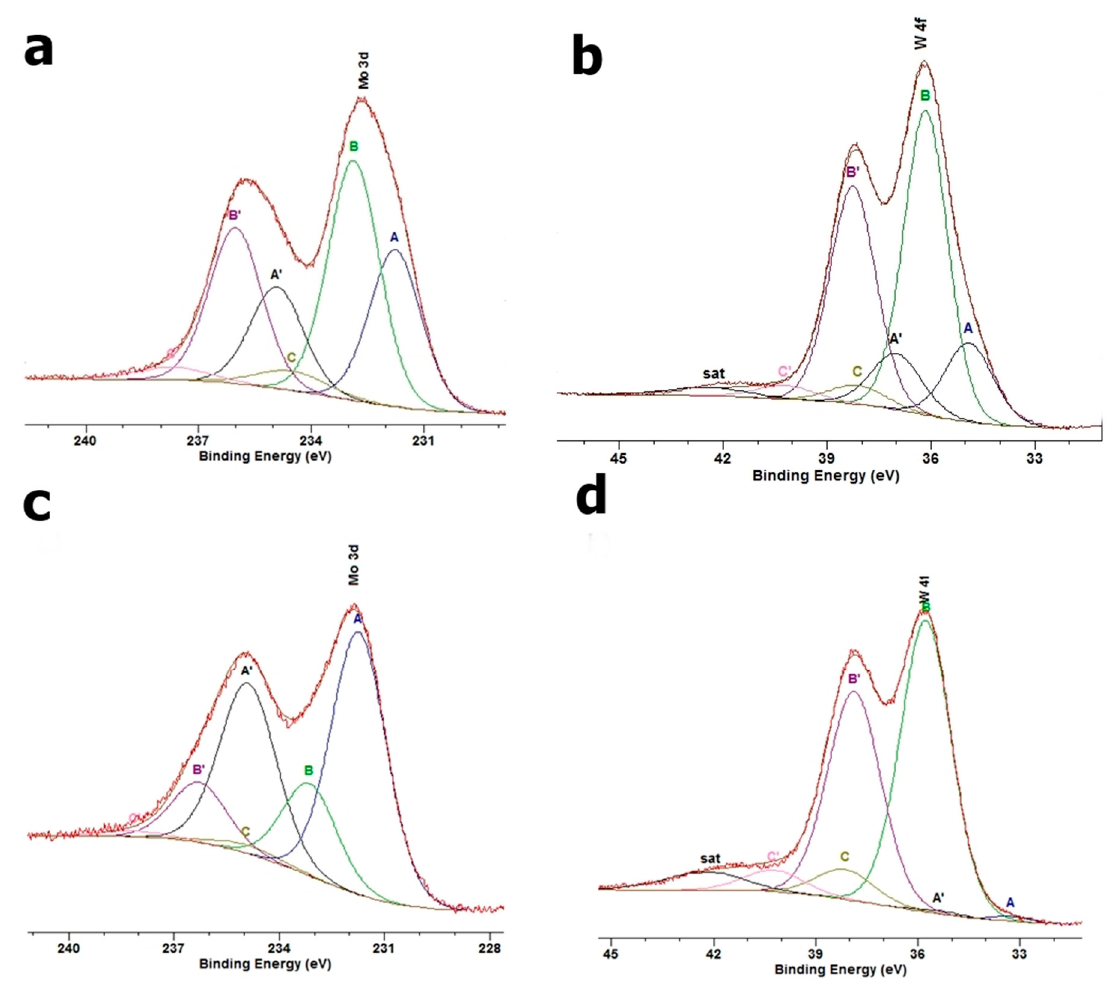
Figure 5. High-resolution XP spectra of ( a ) Mo 3d in a DDTMA-M-Mo, ( b ) W 4f in a DDTMA-M-W, ( c ) Mo 3d in a DDTMA-M-MoW, ( d ) W 4f in a